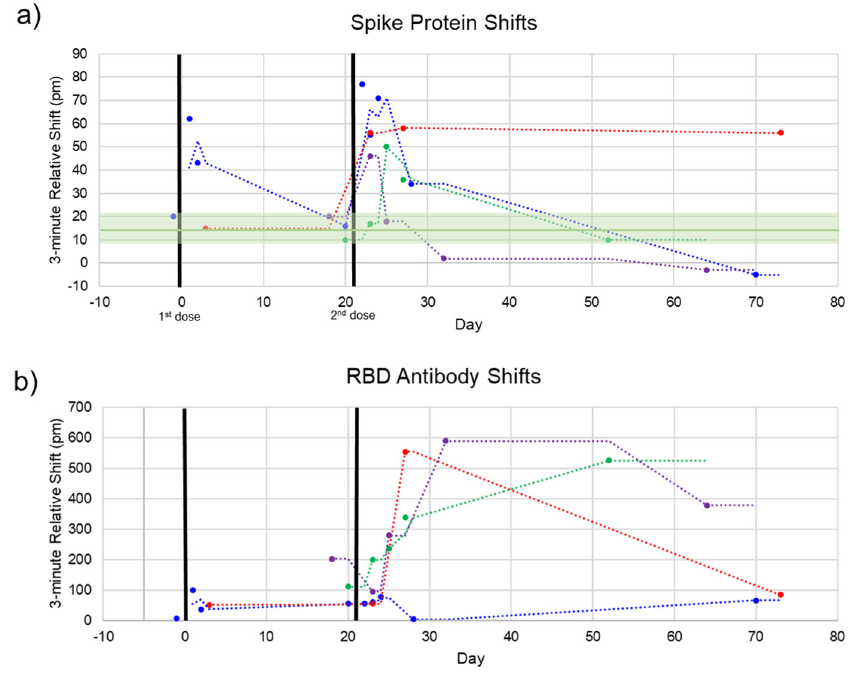
Figure 5. Spike and Anti-Spike Antibody Time Course. Four subjects were repeatedly sampled for serum. Most serum was obtained after the second dose. ( a ) Spike protein rapidly increases after each dose and decreases back to baseline within 1–2 weeks. Pre-vaccination negative control shifts (green line, shaded green = 95% confidence interval) are shown to indicate assay noise. ( b ) Anti-SARS-CoV-2 RBD antibodies over the same time course. In good agreement with clinical trials, our photonic sensors show a modest increase in antibodies after the first dose, reaching high titers after the second dose.